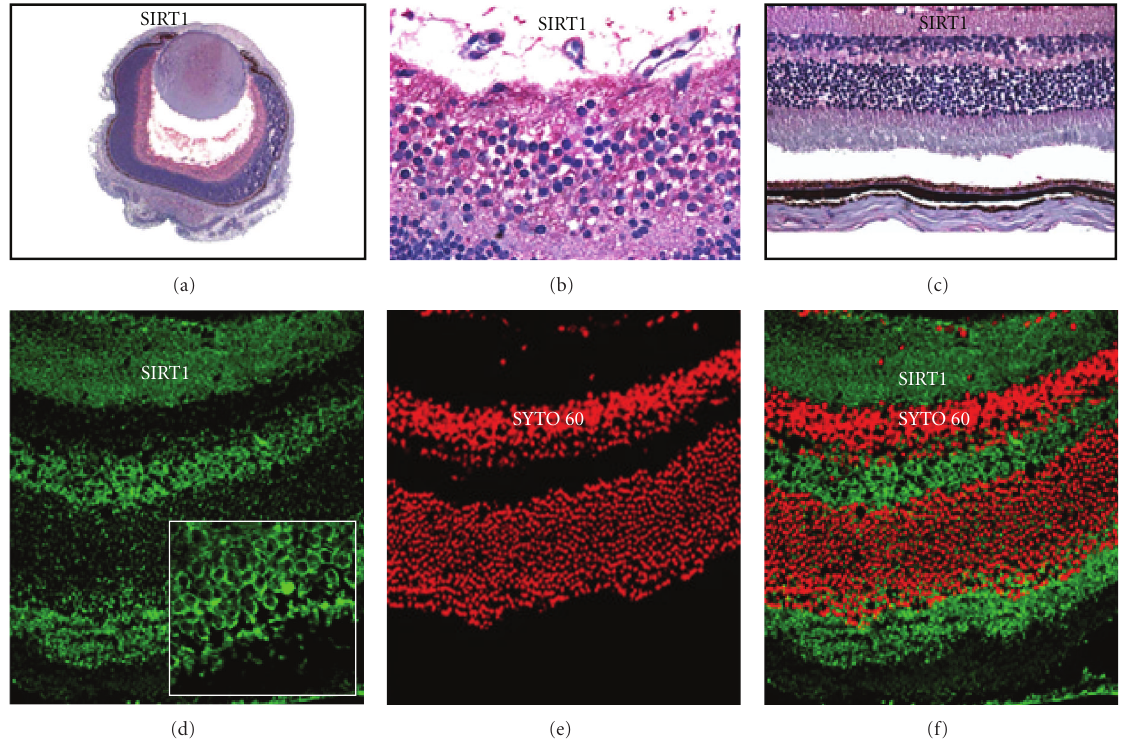
Figure 2: SIRT1 expression in mouse eyes. (a) Postnatal day 1 (P1) mouse eye (50x). (b) Higher magnification of (a) (640x). Ganglion cells and nerve fibre layer stained positive. (c) Inner and outer plexiform layers stained positive while the inner and outer nuclear layers are negative for SIRT1 in this specimen (P244 mouse eye; 400x). (d) SIRT1 staining in adult mouse retina (green). Insert highlights cytoplasmic staining in ONL. (e) SYTO 60 nuclear stain of retinal cell nuclei (red). (f) Composite image of (d) and (e) showing predominant cytoplasmic localization of SIRT1 in this